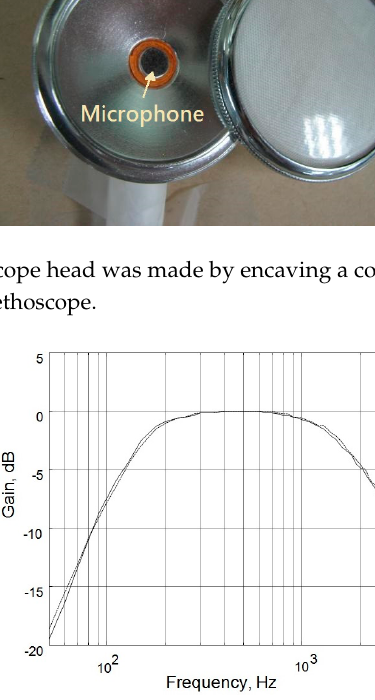
Figure 3. The normalized frequency response of the microphone amplification circuit. Solid line: left channel; dashed line: right channel.